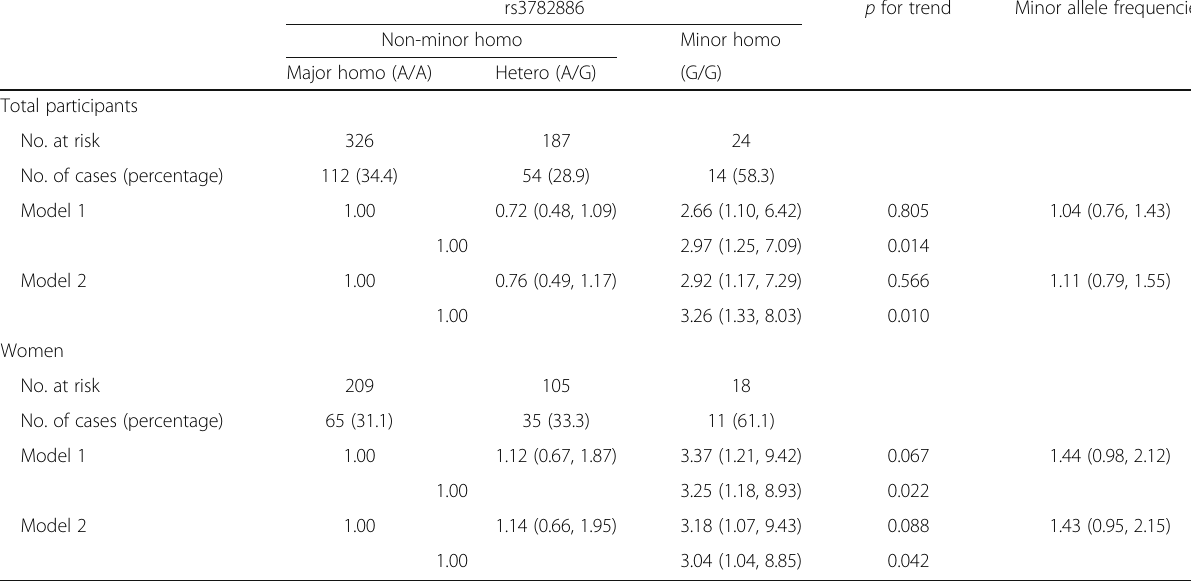
Table 4 Odds ratios (OR) and 95% confidence intervals (CI) for reduced maximum voluntary tongue pressure against the palate (MTP) in relation to rs3782886 genotype rs3782886 p for trend Minor allele frequencies Non-minor homo Minor homo Major homo (A/A) Hetero (A/G)